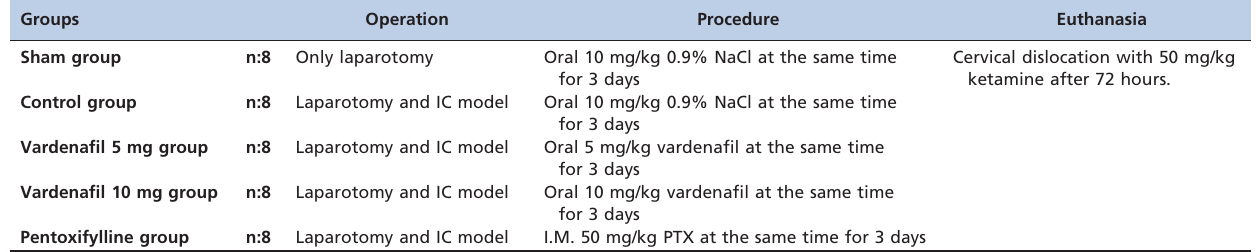
Table 1 - Management of the ischemic colitis rat